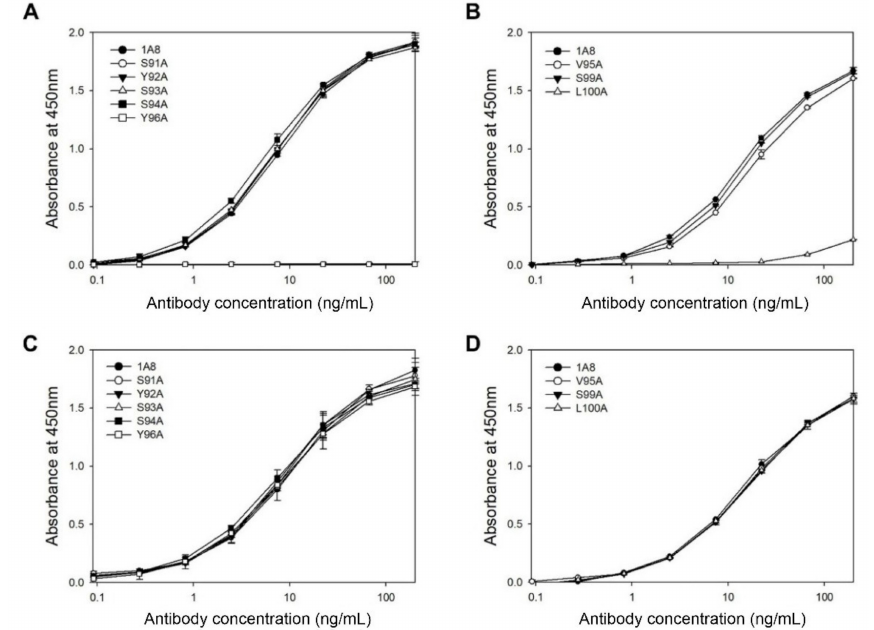
Figure 3. Analysis of the antigen-binding activities of 1A8 variants with an alanine substitution in the LCDR3 ( A , C ) or HCDR3 ( B , D ) by indirect ELISA ( A , B ) and quantitative ELISA ( C , D ). The culture supernatants containing each antibody (200 ng/mL) were serially diluted and subjected to the ELISAs. Values were obtained from duplicate wells and are expressed as the mean ±